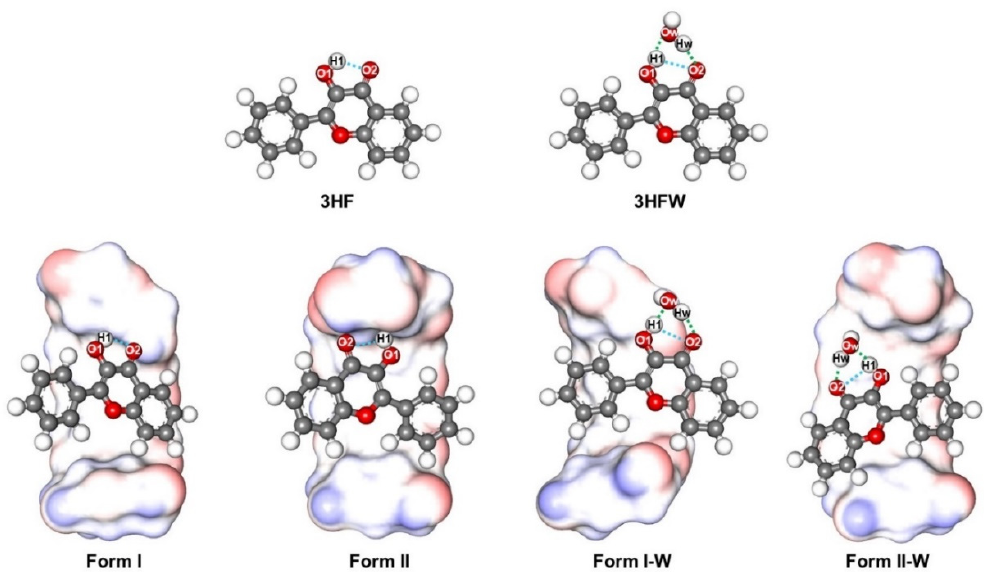
Figure 4. All S 0 optimized structures of 3HF, 3HFW, and the different conformations of the 3HF/ γ -CD inclusion complexes (Form I and Form II) as well as its inclusion complex with a water molecule (Form I-W and Form II-W) computed by PBE0/def2-SVP level of theory. The blue and green dot lines represent intraHB in 3HF and interHBs between 3HF and a water molecule, respectively. Table 1. A summary of the important bonds and distances involving PT process of enol form for all complexes in the S 0 and S 1 states.